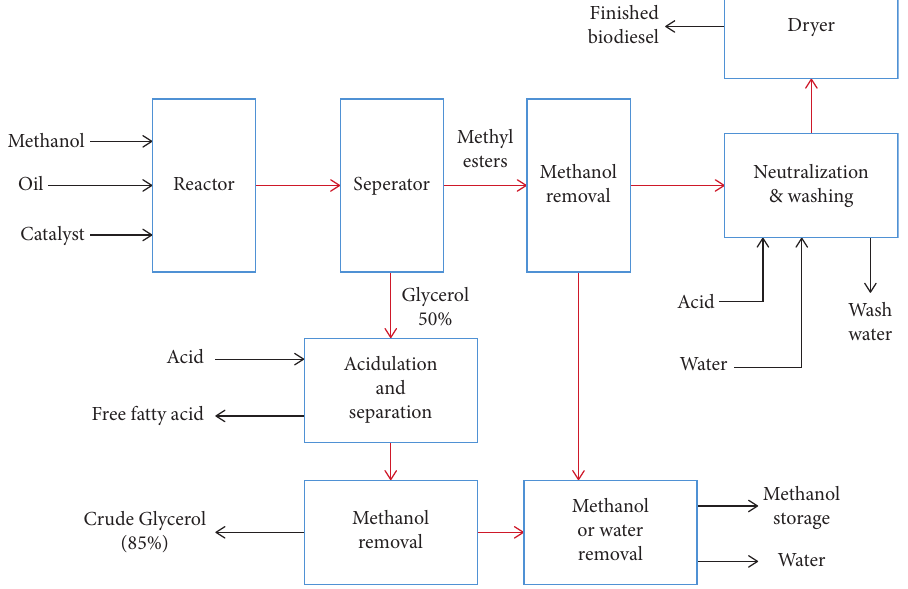
Figure 2: Schematic flow of the biodiesel production process